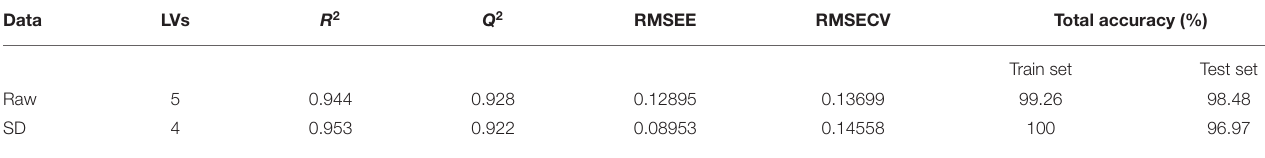
FIGURE 3 | The average chromatograms of the 10 regions of W. cocos samples with different parts: (A) Poria ; (B) Poriae cutis; (C) five mixed reference substances. TABLE 1 | Parameters for PLS-DA models in part discrimination based on raw and SD FT-NIR datasets.